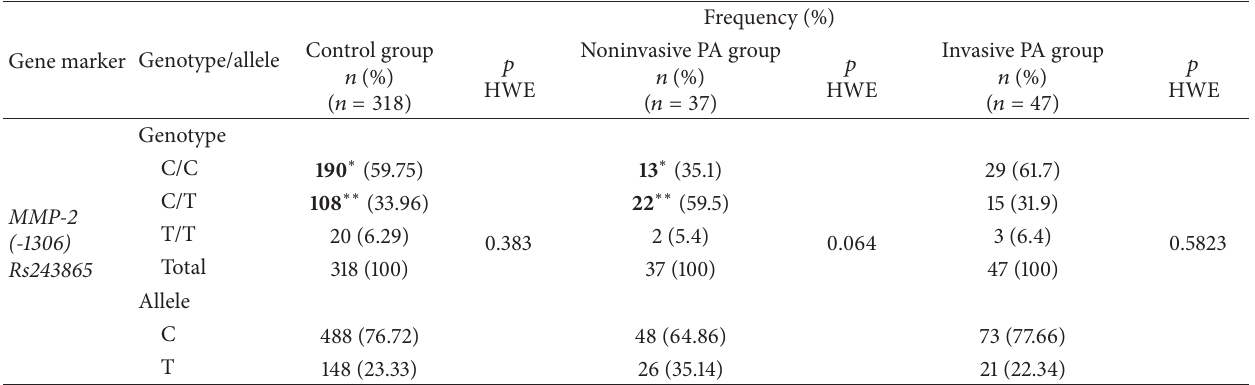
Table 6: Frequency of MMP-2 (-1306 C/T) genotype in the patients with pituitary adenoma (PA) and in the control group by PA invasiveness.